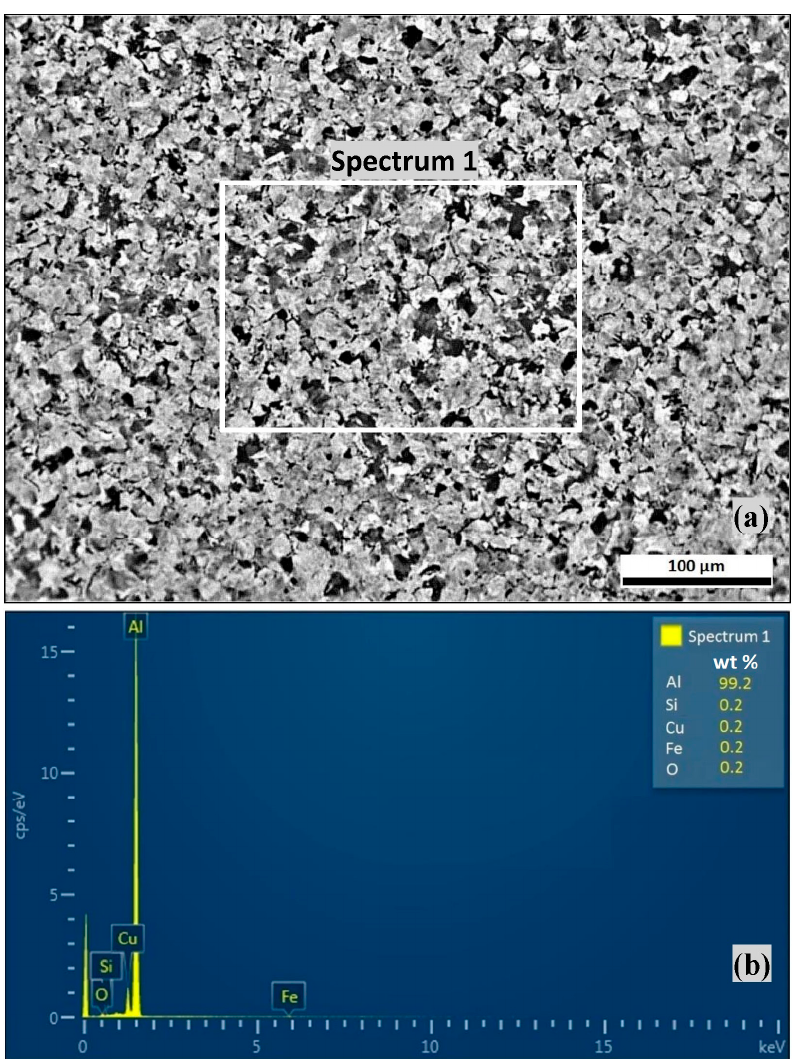
Figure 12. Schematic plot of the SEM results; ( a ) micromorphology of the stirring zone and ( b ) EDS composition for the selected region of the stirring zone processed by the square-shape pin tool.